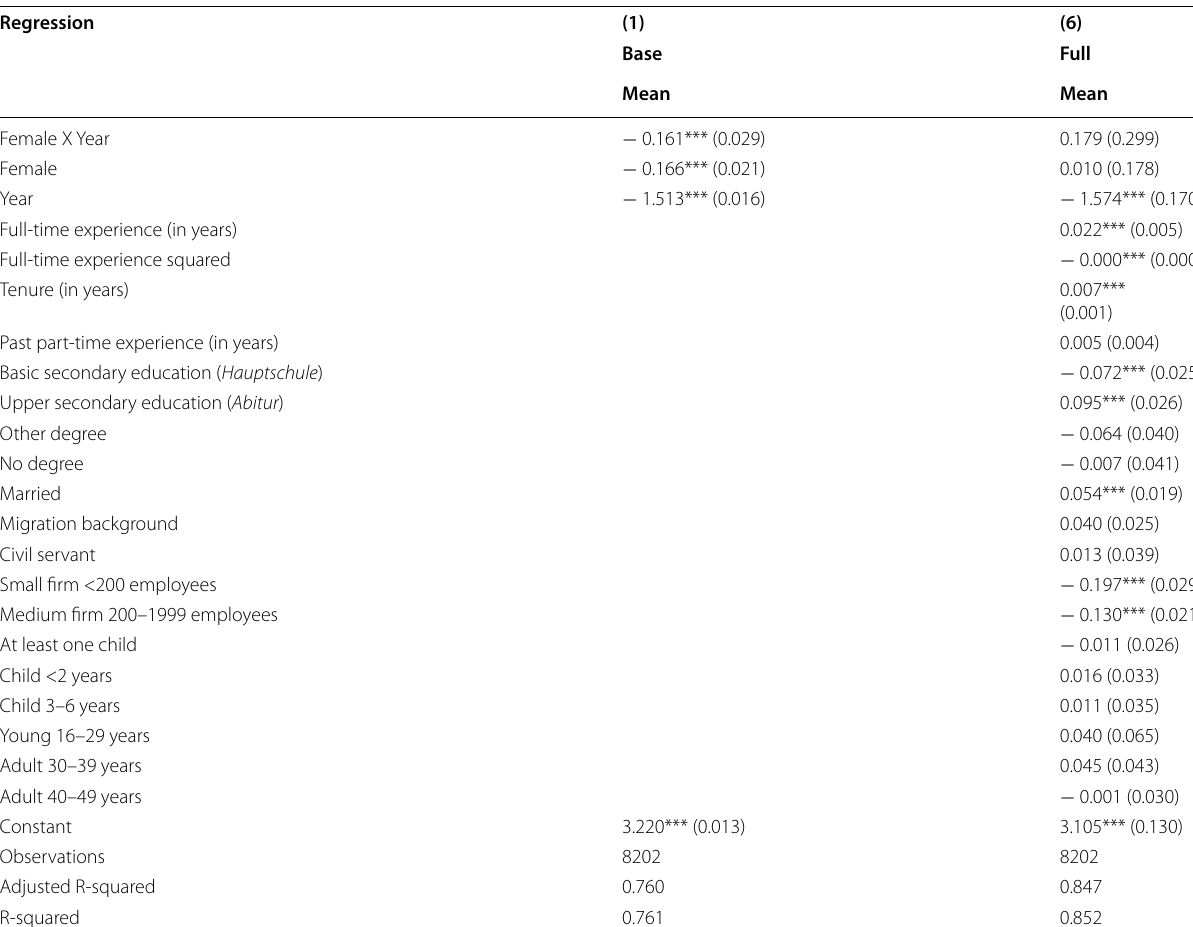
Table 4 Base and full OLS regressions of log hourly